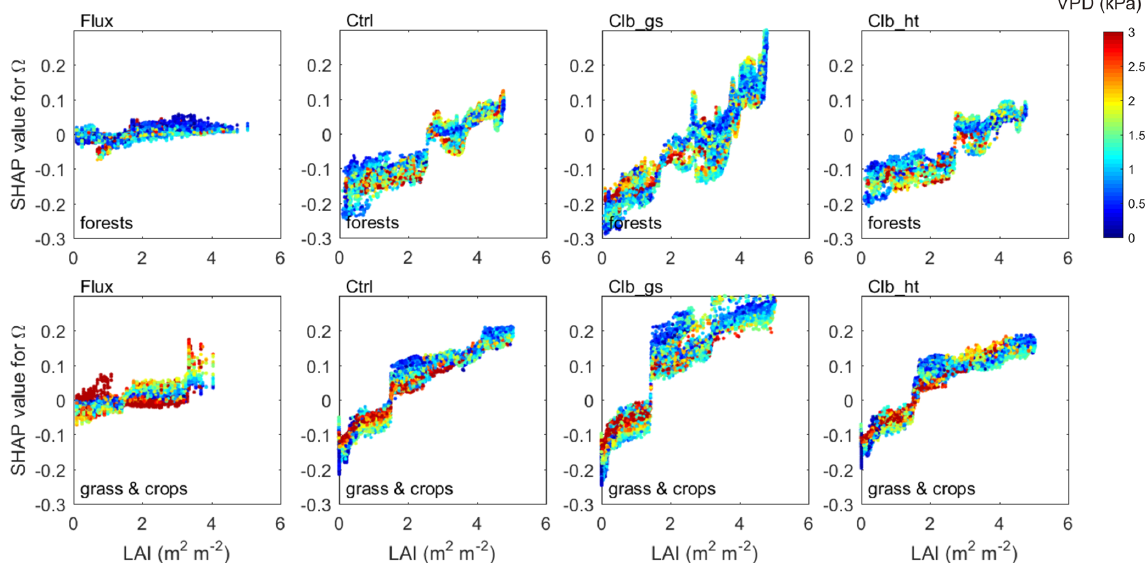
Figure 8. Same as Fig. 7 but for interactions between VPD and